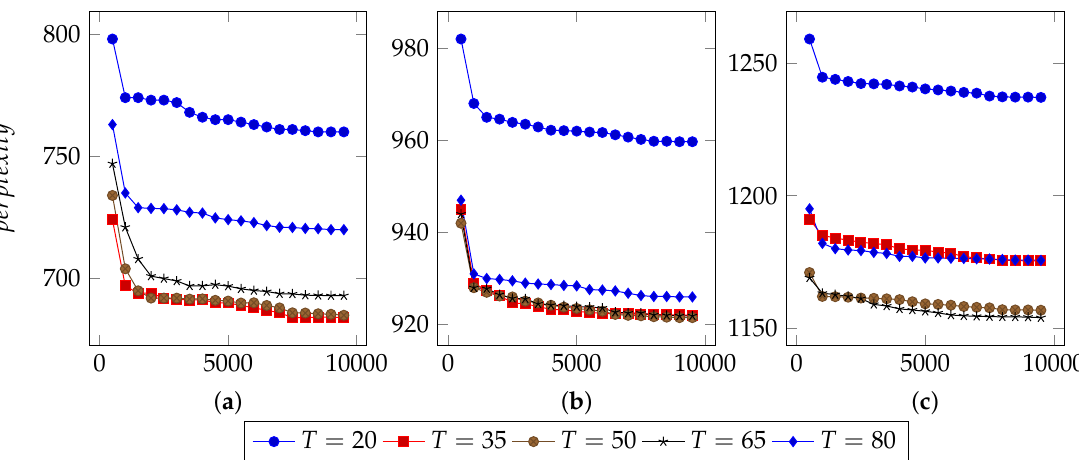
Figure 4. Selection of I for CoAP. ( a ) Perplexity for model with 40% n-grams used; ( b ) Perplexity for model with 60% n-grams used; ( c ) Perplexity for model with 80% n-grams